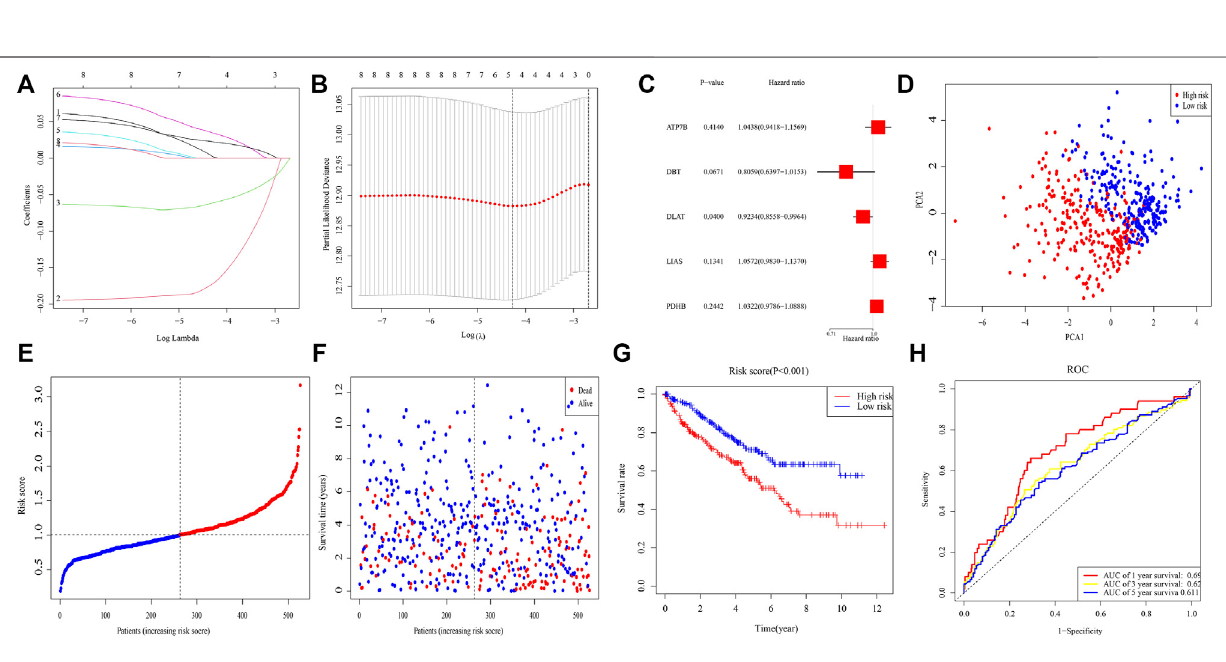
Frontiers in Genetics |